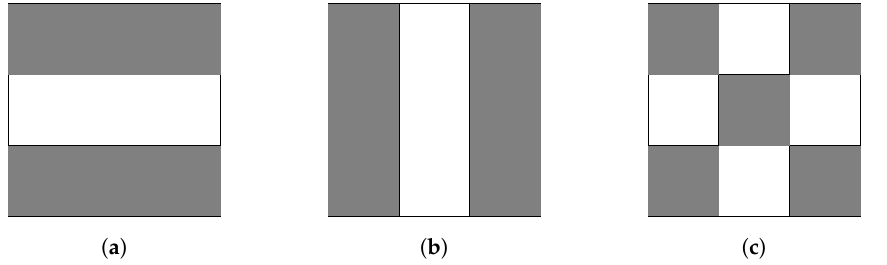
Figure 1. While standard clustering divides either rows or columns, the biclustering divides both. ( a ) Row clustering; ( b ) column clustering; ( c )